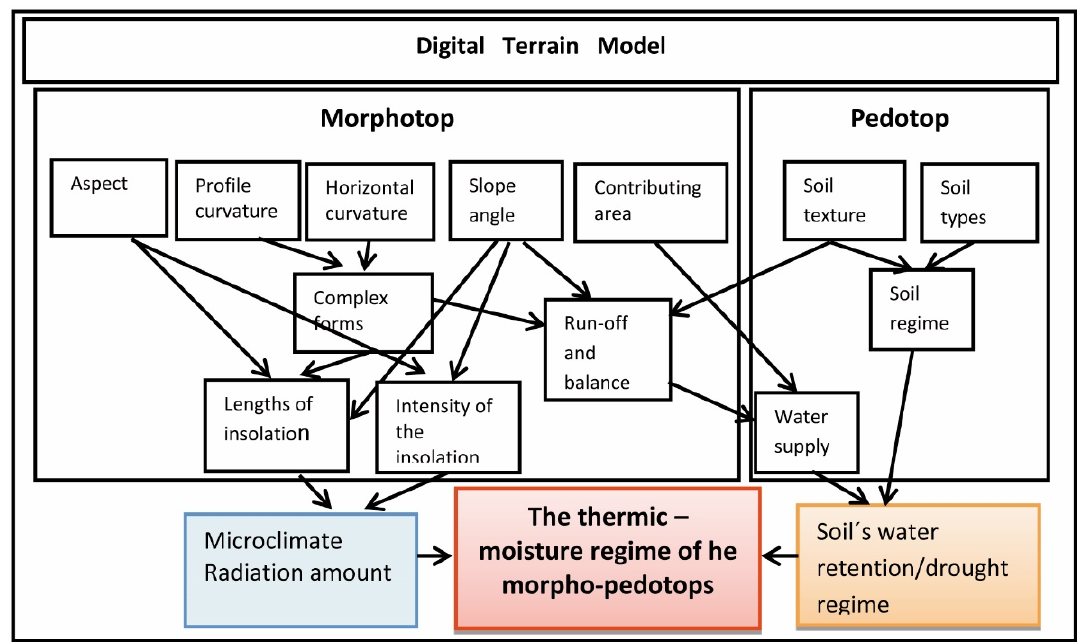
Figure 1. Sequential interpretation scheme.